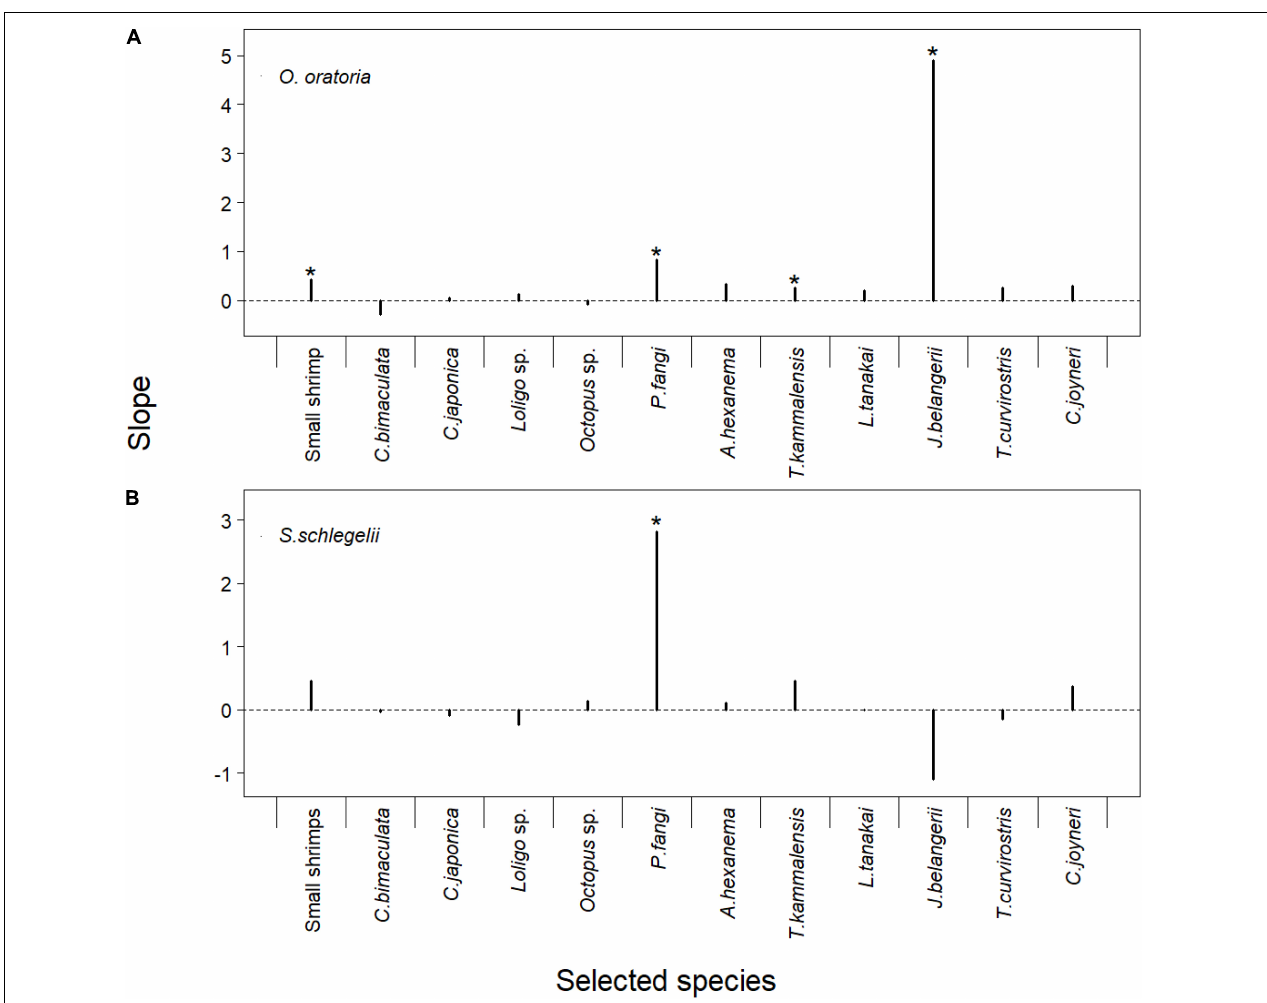
FIGURE 7 | Linear regression model of corresponding multipliers of fishing mortality rates for the “selected” species and biomass of O. oratoria (A) or S. schlegelii (B) . The detailed results presented in Supplementary Table 4 . The “selected species” showed in the X -axis. The regression models whose P -values were lower than 0.05 were marked with